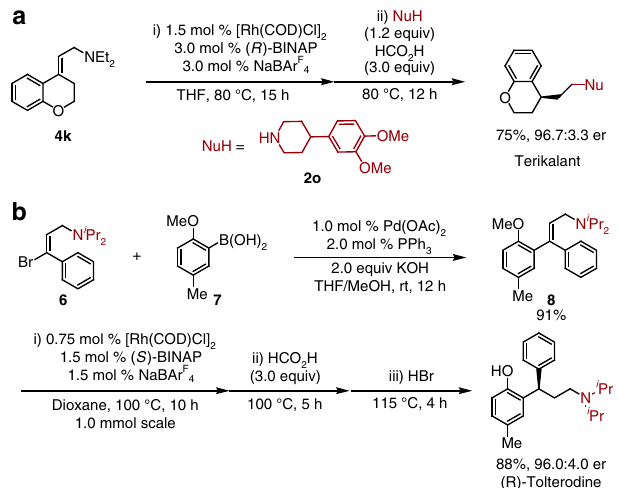
Fig. 5 Synthetic application of rhodium-catalyzed asymmetric reductive amination of allylamines. a Enantioselective synthesis of Terikalant from allylic diethylamine 4k . b Enantioselective and modular synthesis of ( R )-Tolterodine from vinyl bromide 6 . See supplementary methods for